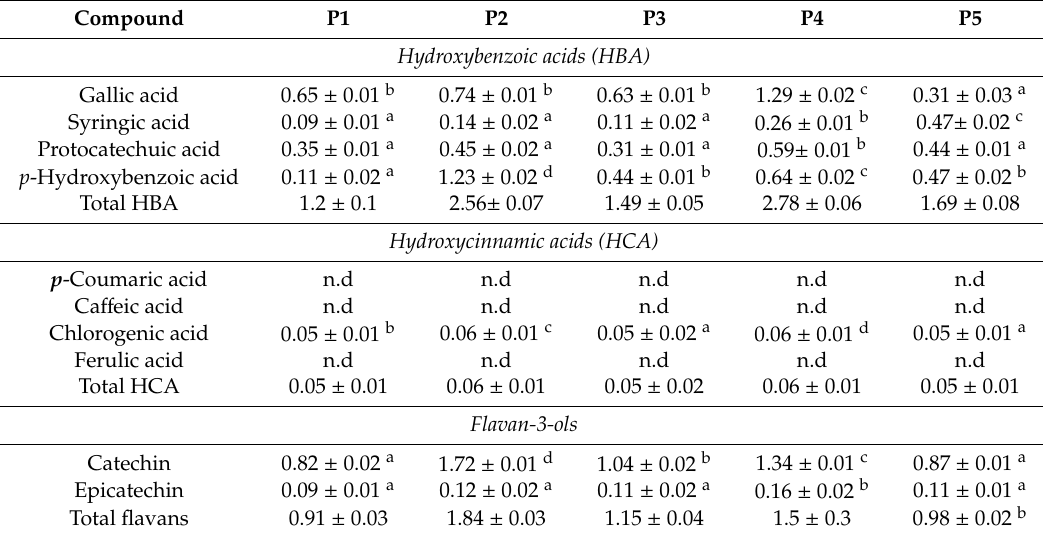
Table 1. Phenolic composition (mg g − 1 ) of Arbutus unedo extracts determined by high-performance liquid chromatography (mean ±